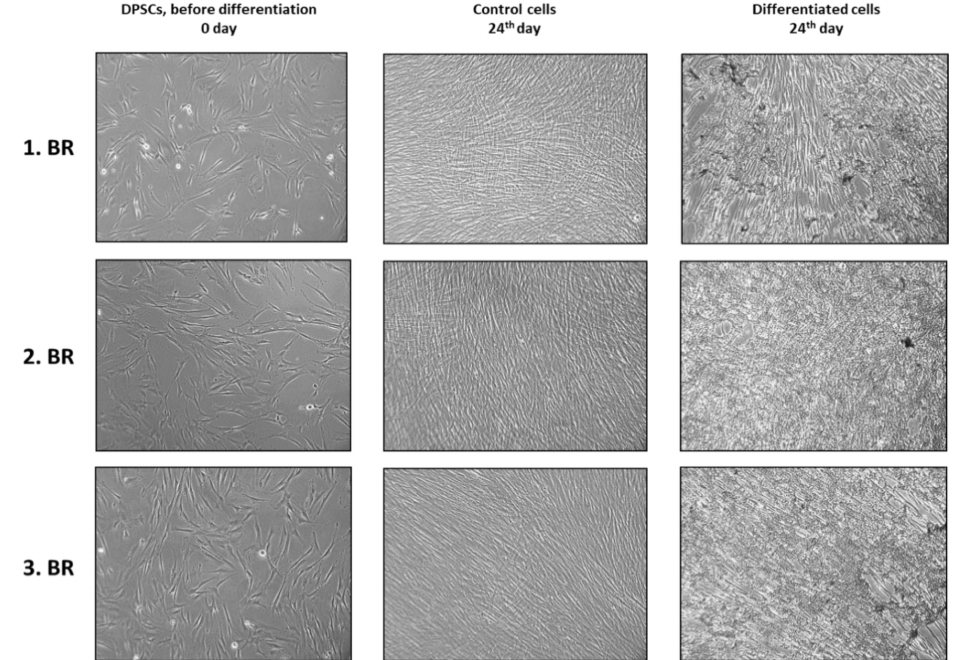
Figure 2. The visual appearance of undifferentiated (control) and differentiated cells on the 24th day after osteogenic medium application. Controls were cultured in a DPSCs growth medium during the experiment. Cellular morphology correlates with the osteogenic differentiation potential. Representative micrographs were taken by phase contrast technique at magnification 100 ×